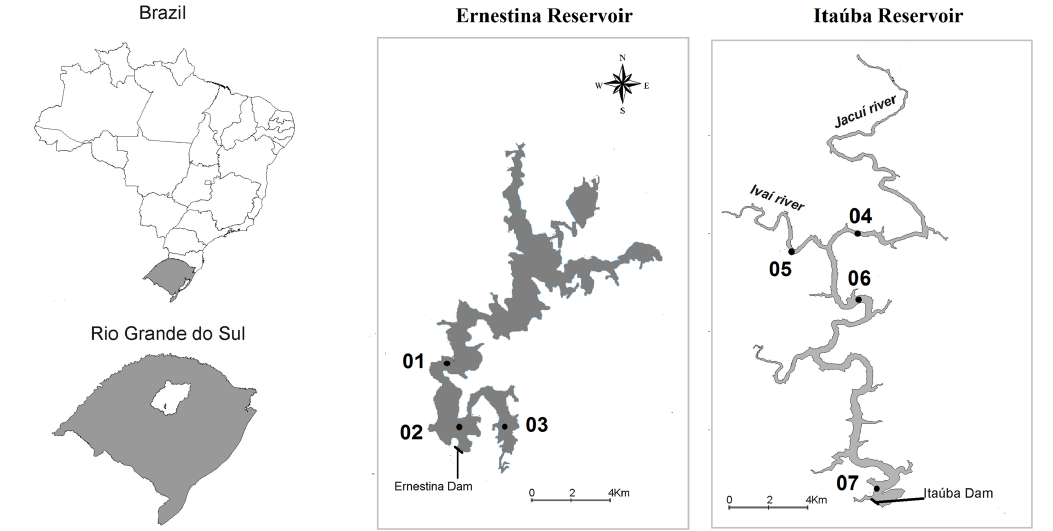
Figure 1. Map showing the position of the reservoirs in Brazil (top left), in Rio Grande do Sul state (bottom left), and the distribution of sampling stations in the reservoirs Ernestina (centre) and Itaúba